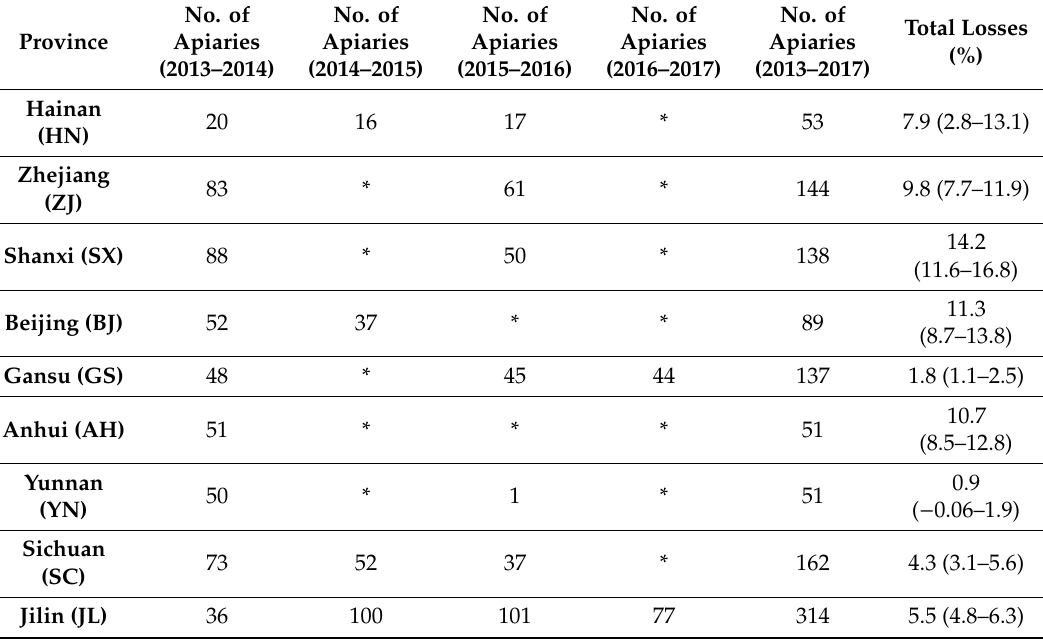
Table 1. Provincial total winter losses (%, CI 95%) and number of apiaries in 2013–2017.